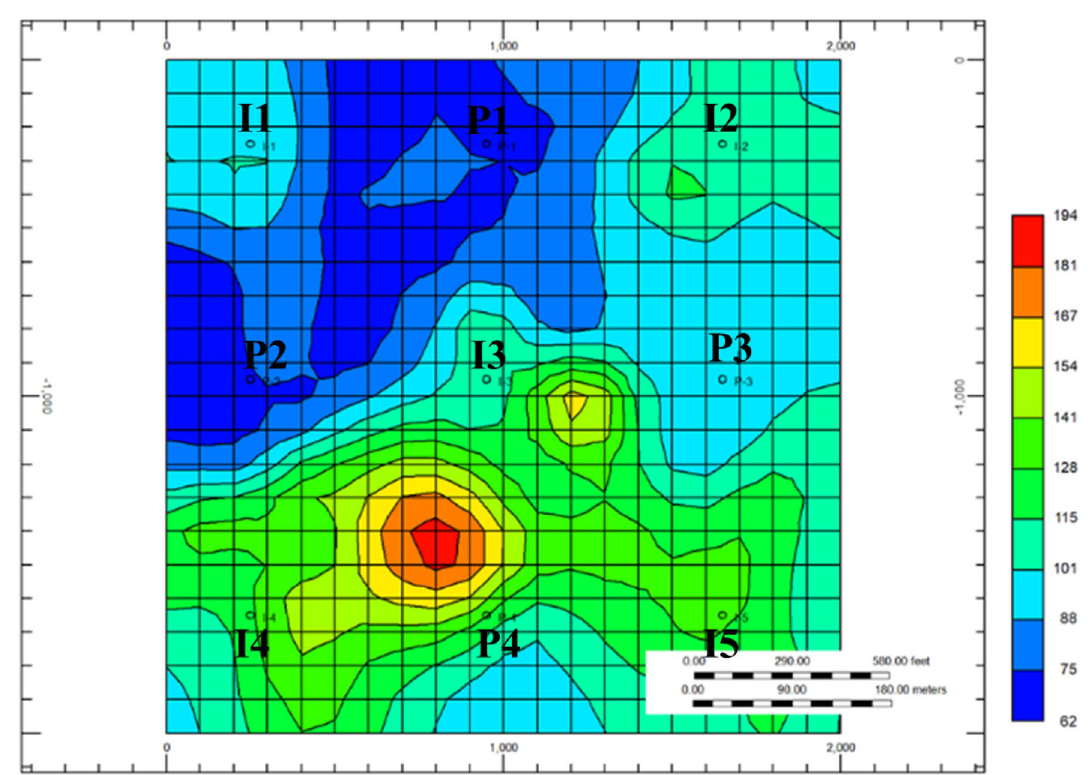
Fig. 3 Permeability distribution in heterogeneous cases I and II (validation of